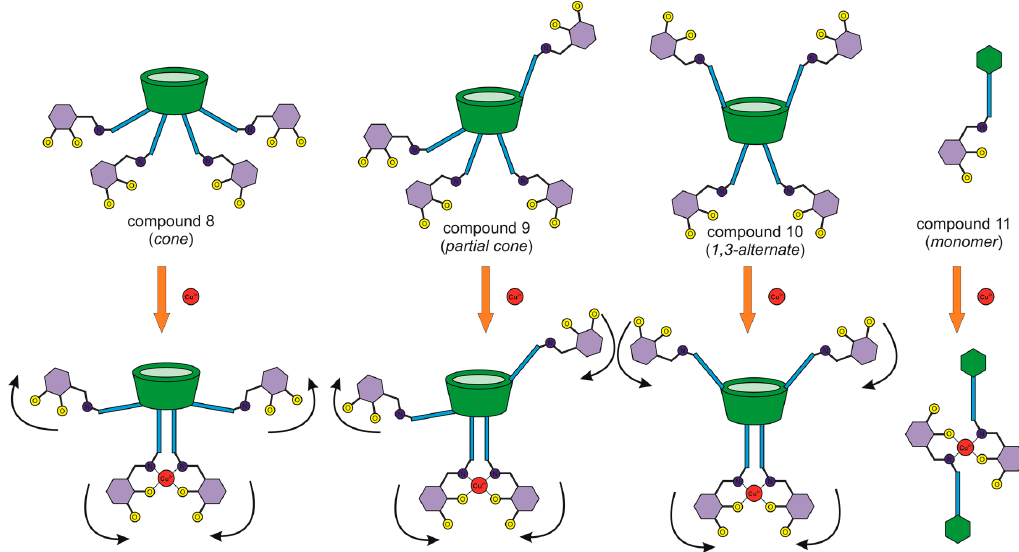
Figure 4. Cartoon images of complexation of thiacalix[4]arenes 8 – 10 and monomer 11 with the copper (II) cation.